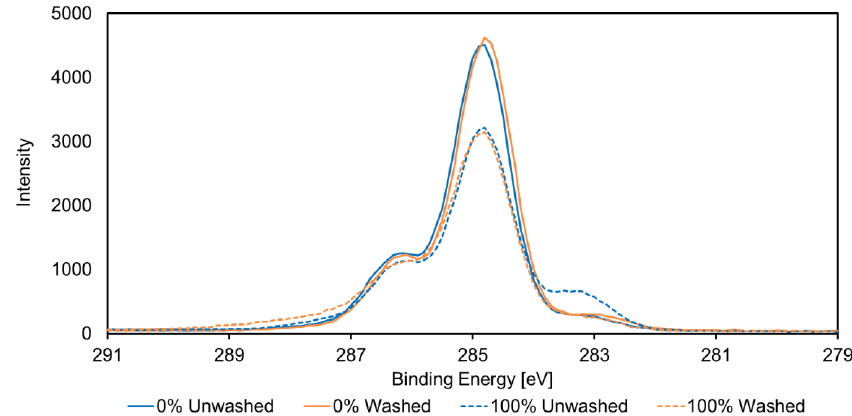
Figure A5. XPS Carbon 1s spectra of laser-etched Whatman #1 chromatography paper. Unetched paper (0%) was compared to paper etched at the highest grayscale value (100%). The washed paper was simply dipped into DI H 2 O and allowed to dry at room temperature.